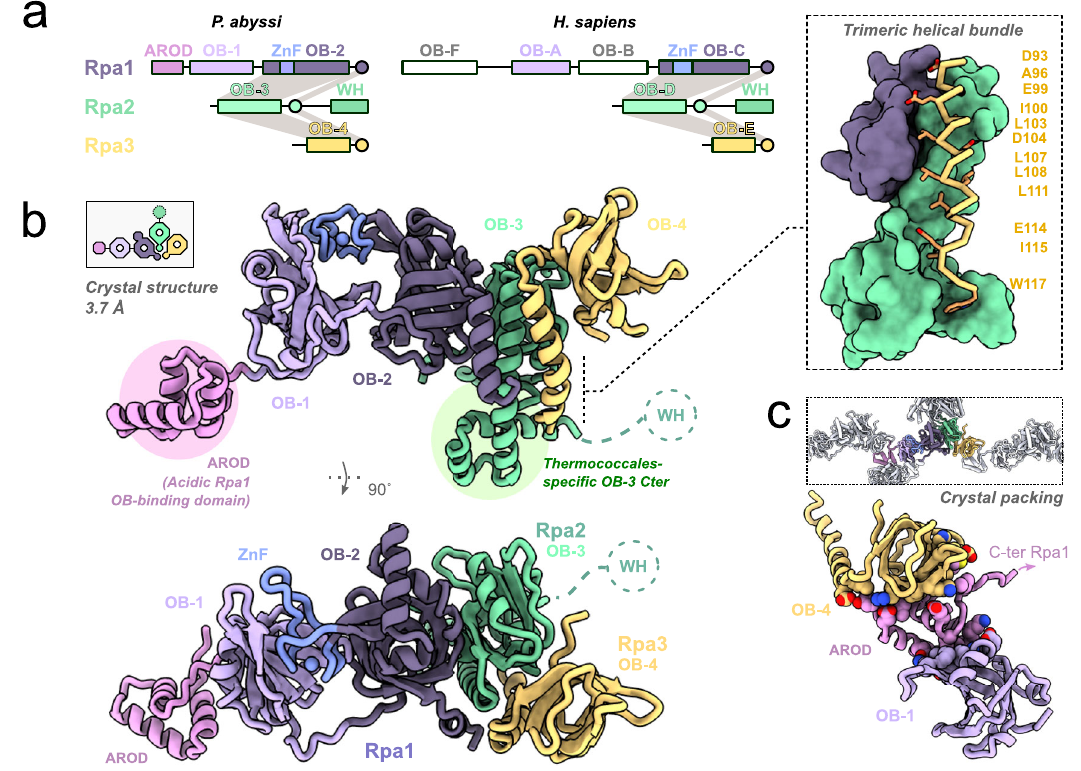
Fig. 1 | Structure of the archaeal RPA. a Domain diagrams of PabRPA and human RPA. b Two orthogonal views of the full-length PabRPA crystal structure at 3.7Å with a focused view on the trimeric helical bundle (top right). c Representation of